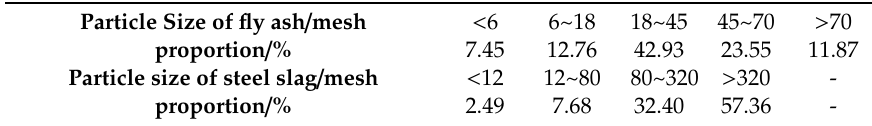
Table 2. Size distribution of the waste residue substrate.